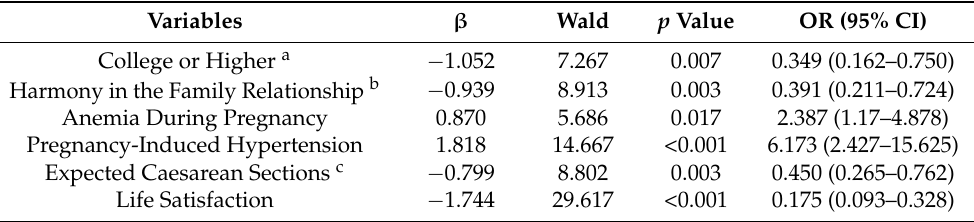
Table 2. Logistic regression analysis for variables predicting antenatal anxiety symptoms. Variables β Wald p Value OR (95% CI) College or Higher a ´